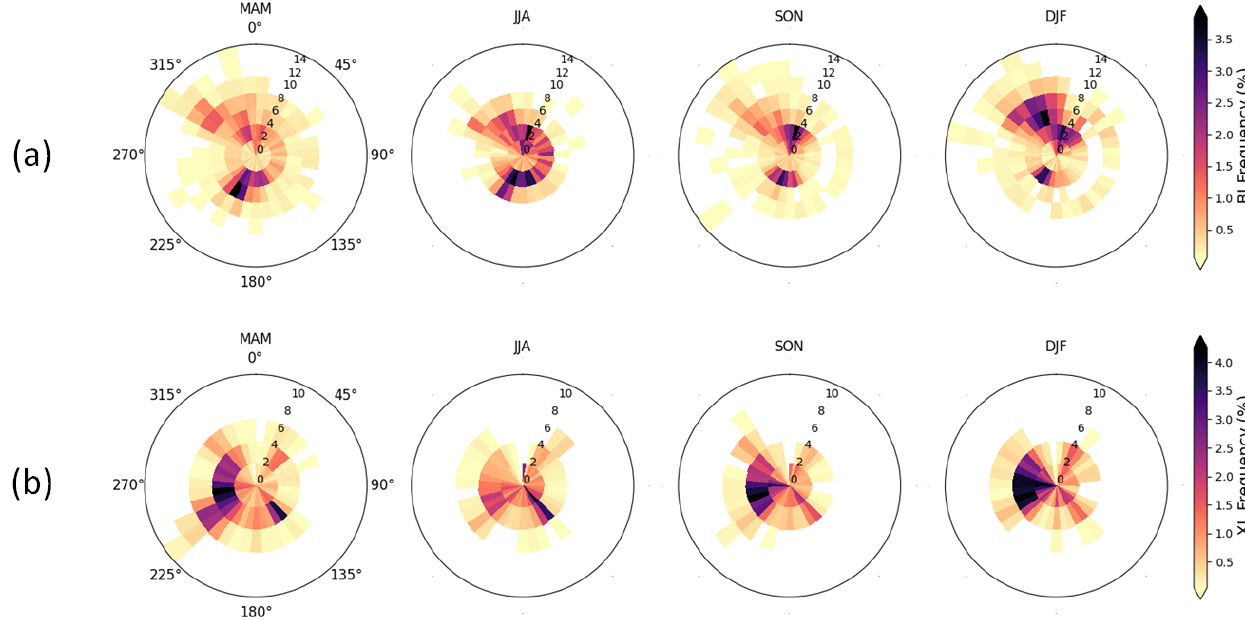
Figure 3. Wind frequency as a function of wind speed (ms − 1 ) and wind direction ( ◦ ) in spring (MAM), summer (JJA), autumn (SON), and winter (DJF) at BJ (a) and XL (b) from October 2018 to September